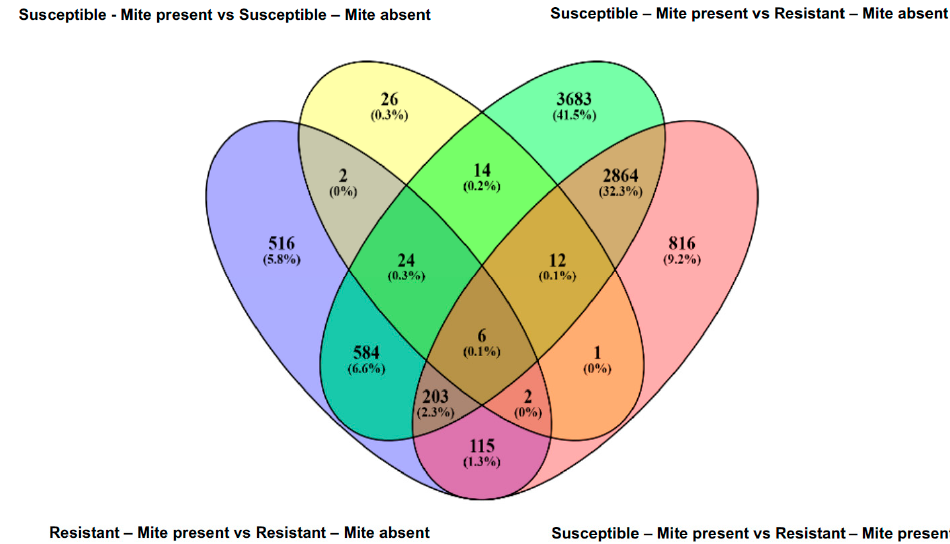
Figure 2. Venn diagram of DEGs in the susceptible and resistant wheat exposed to wheat curl mite herbivory.